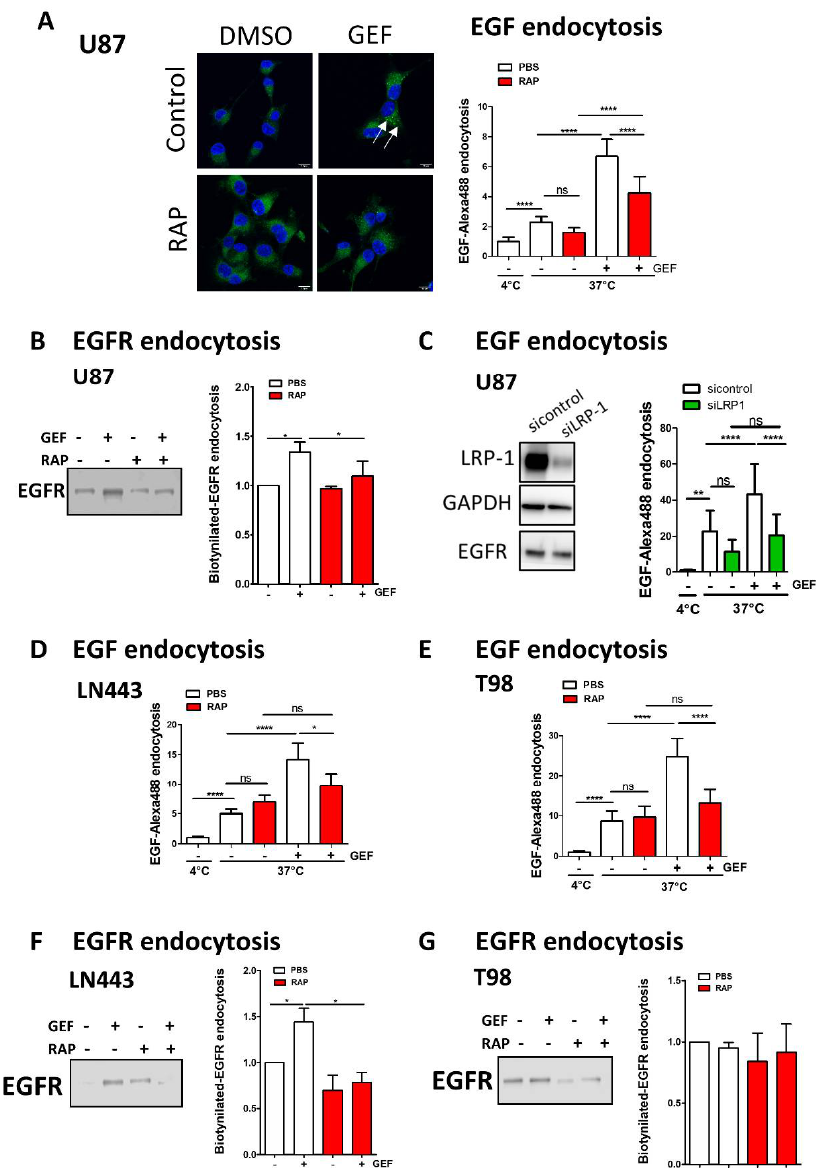
Figure 5. Inhibition of LRP-1 decreases GME. ( A ) EGF-Alexa 488 for EGF-internalisation assay were performed on U87cells in presence in the culture medium of gefitinib (20 µM) and/or of RAP (500 nM) for LRP-1 inhibition. Nucleuses were stained with DAPI. Left panel: confocal images showing in green EGF-Alexa Fluor 488 internalised upon incubation at 37 °C. Scale bar = 12 µm. Right panel: quantification of EGF-Alexa Fluor 488 fluorescence intensity was performed on 20 cells on 3 independent experiments. Data, reported as column histograms, are the mean +/− s.d. ( B ) Following cell-surface biotinylation, cells were incubated in complete media, with or without gefitinib (15 µM) and with or without RAP (500 nM) for 3 h. Cells were treated with MESNa agent to remove biotin present on cell-surface proteins. After purification, biotinylated proteins were then subjected to EGFR immunoblot. Top panel: quantification of EGFR protein bands (mean of 4 independent experiment). Lower panel: immunoblot showing the endocytosis of biotinylated EGFR. ( C ) Left panel: downregulation of LRP-1 expression was obtained by silencing using siRNA-LRP-1. EGF-internalisation assay was further performed on U87 transfected with siRNA-control (white bars) and siRNA-LRP-1 (green bars). Right panel: LRP-1 silencing was confirmed by immunoblotting 72 h after transfection. The EGFR protein level was controlled and remained constant in both conditions. GAPDH was used as the loading control. ( D , E ) EGF-internalisation assay was performed in LN443 ( D ) and T98 ( E ) cells as described in A. ( F , G ) EGFR-internalisation assay was performed in LN443 ( F ) and T98 ( G ) cells as described in B. Data, reported as column histograms, are the mean with 95% CI. * p < 0.5, ** p < 0.01; **** p < 0.0001; ns: not